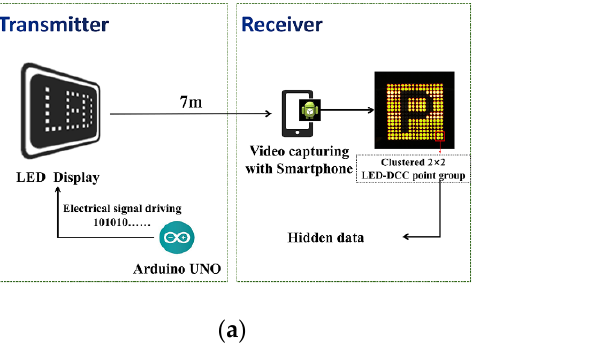
Figure 4. ( a ) The schematic diagram and ( b ) photography of the long-distance, real-time LED-DCC system experimental setup. Table 1. The experimental system hardware